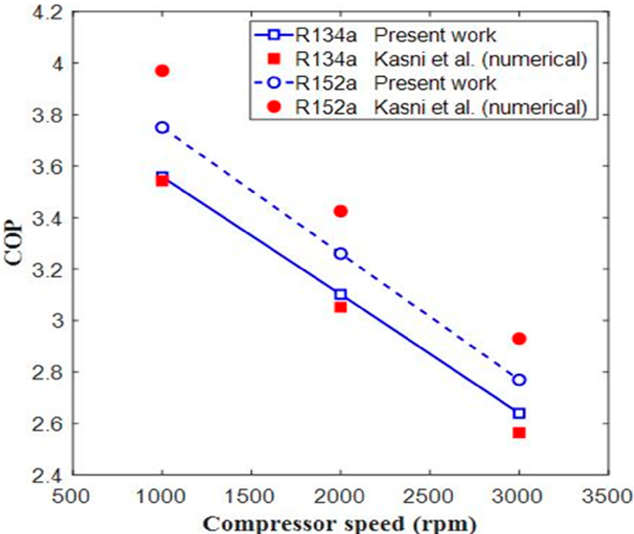
Figure 6 . Comparison of COP values of systems running with R134a and R152a at different compressor speeds [9] .